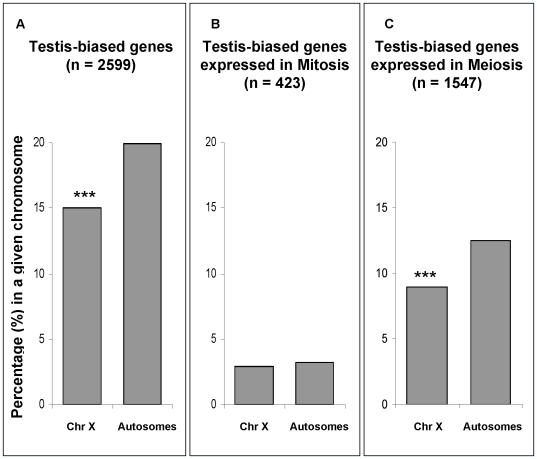
Chromosomal percentages of testis-biased genes.In gray, percentage of testis-biased genes in a given chromosomal location, i.e. autosomes and X chromosome (Chr X). (A) Percentages of all testis-biased genes regardless their spermatogenic phase of expression; (B) percentages of testis-biased genes over-expressed in mitosis; and (C) percentages of testis-biased genes over-expressed in meiosis (C). Sample sizes (n) for each group of testis-biased genes are shown in parentheses. For instance, panel (A) shows that approximately 15% of all X-linked genes are testis-biased (85% are non-testis-biased). Panel (B) and (C) are subsets of all testis-biased genes (panel A). Significant deviations (Fisher exact test) are indicated by ***P 10−5.